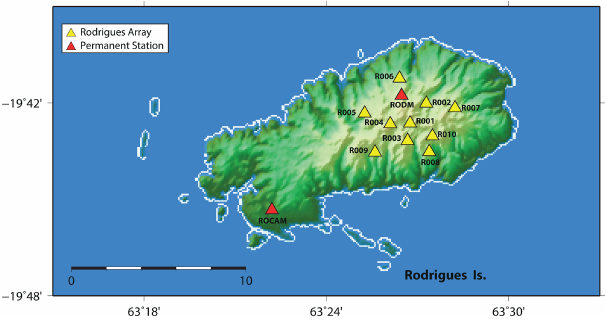
Figure 2. Locations of individual stations in Rodrigues array (yel- low triangles). Red triangles denote permanent stations